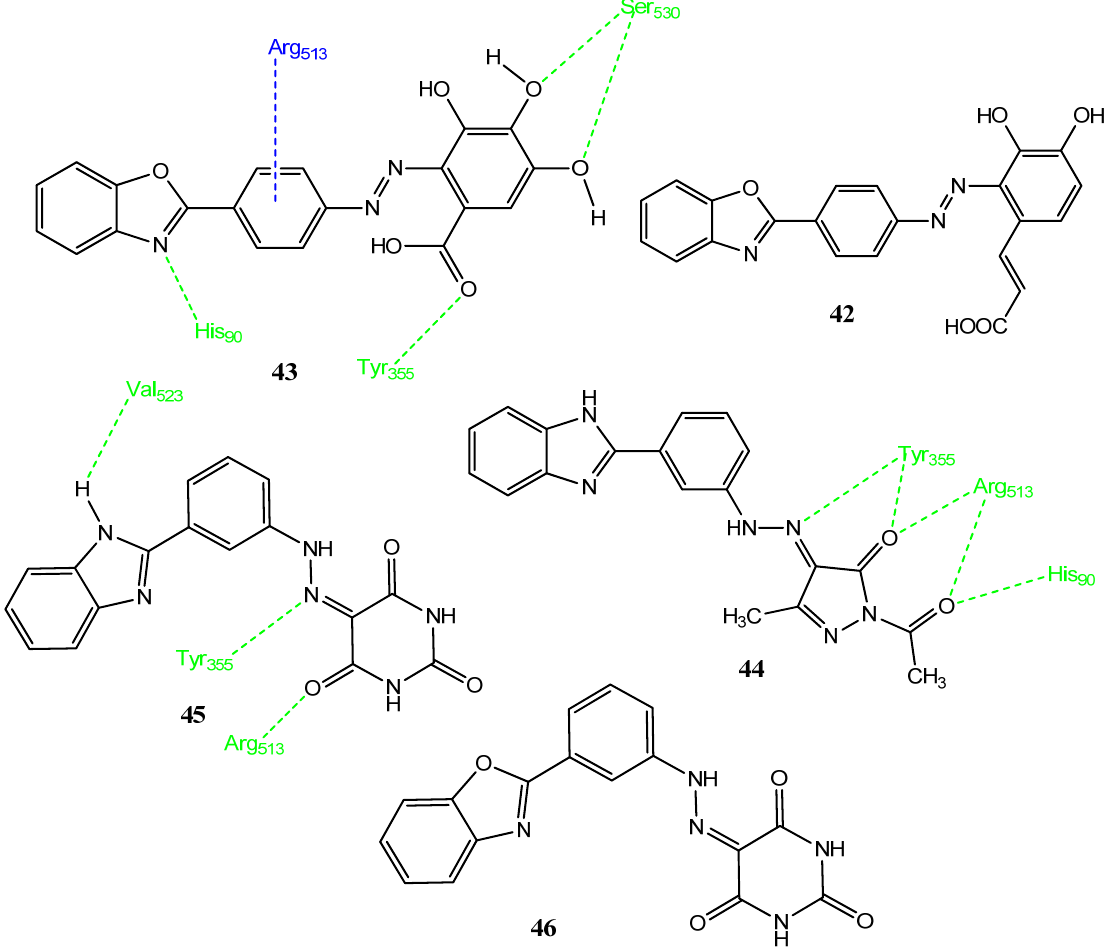
Figure 9. Benzimidazole and benzoxazole hybrid molecules and their interactions with COX-2.